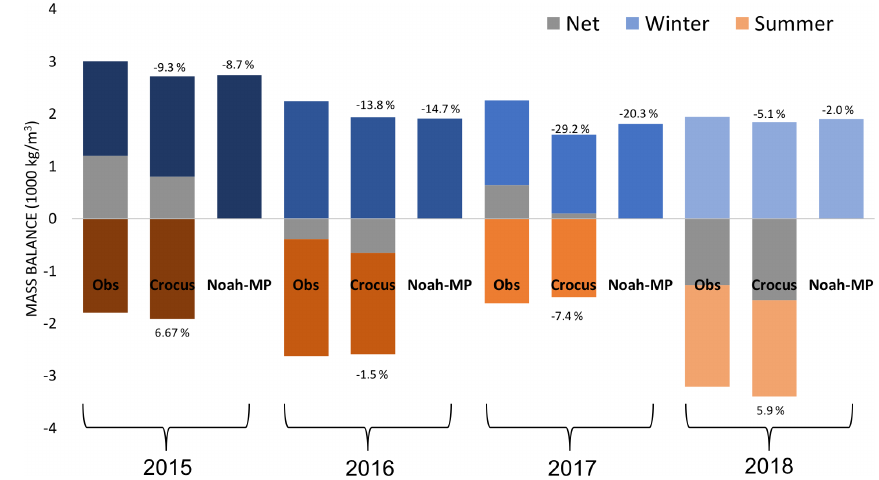
Figure 9. Box plot of winter, summer and net balance for the mass balance years 2015–2018 for Rembesdalskåka. Only winter mass balance is shown for